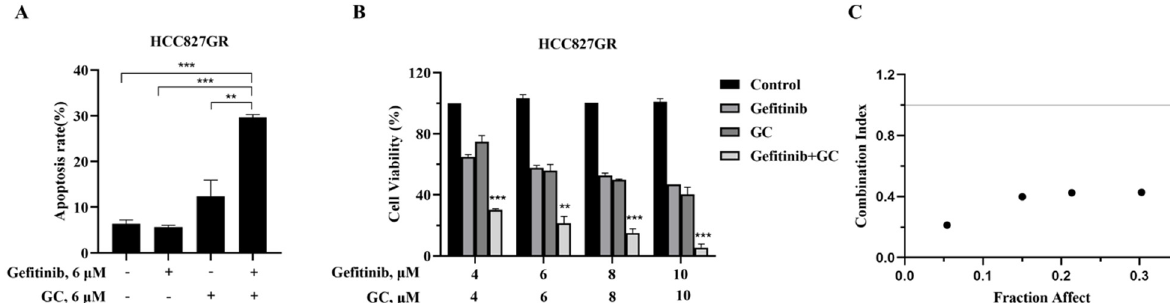
Figure 3. Glycyrol sensitizes HCC827GR cells to gefitinib. ( A ) Apoptosis induction by gefitinib alone or in combination with glycyrol in HCC827GR cells. ( B ) HCC827GR cells were exposed to glycyrol, gefitinib or their combination for 48 h, and the changes of cell viability were measured by crystal violet staining. ( C ) The combination index was calculated using Chou–Talalay equation based on the data generated above. ** p < 0.01, *** p <